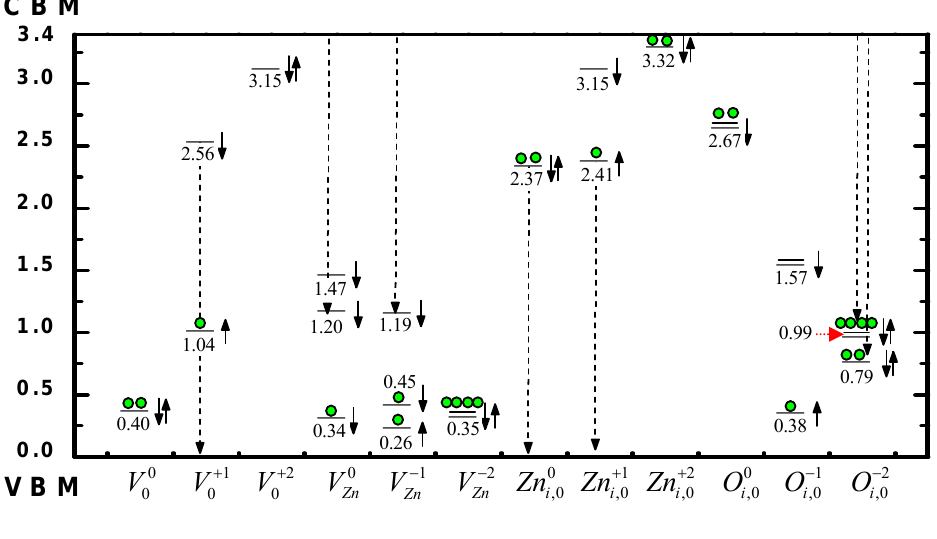
Figure 9. Calculated energy levels of native defects in the band gap of ZnO. Based on table 1 of Ref.